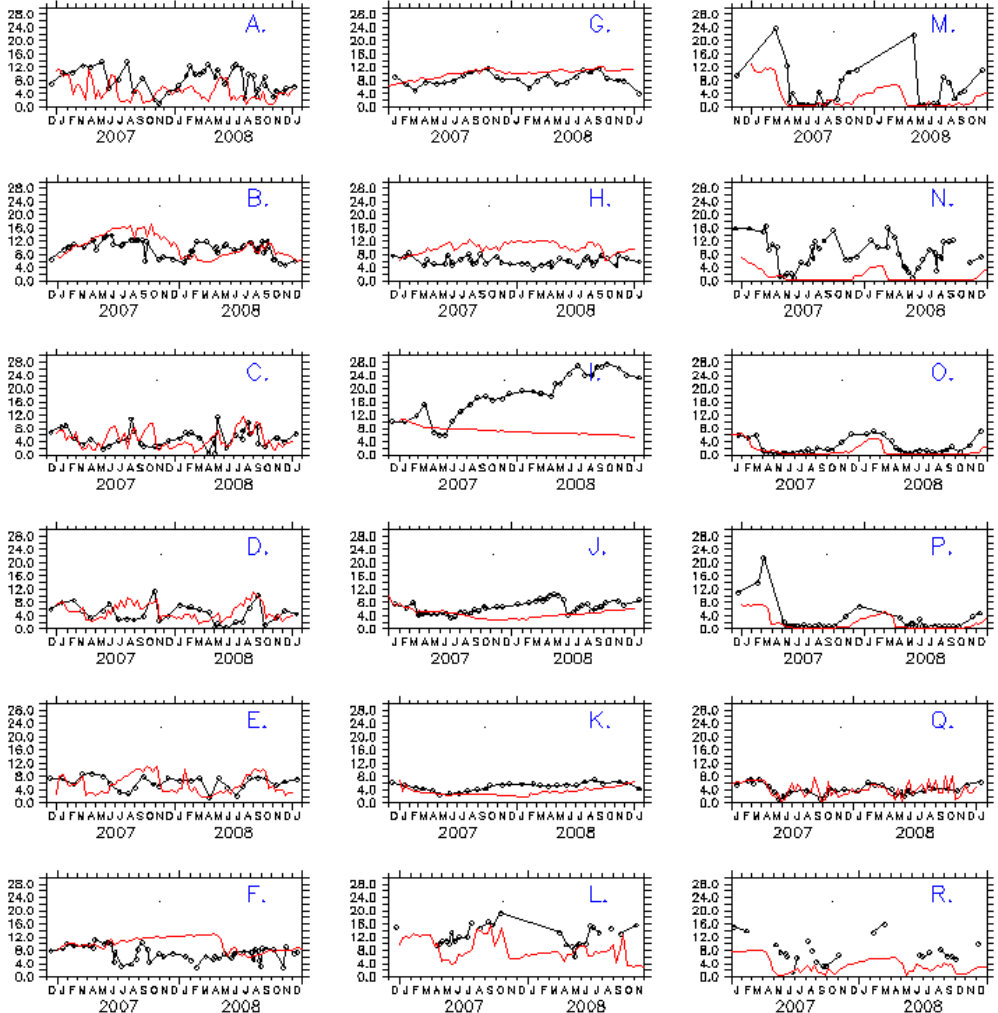
Fig. 7. Seasonal variability of DIN in bottom layer. Notations same as in Fig. 6.